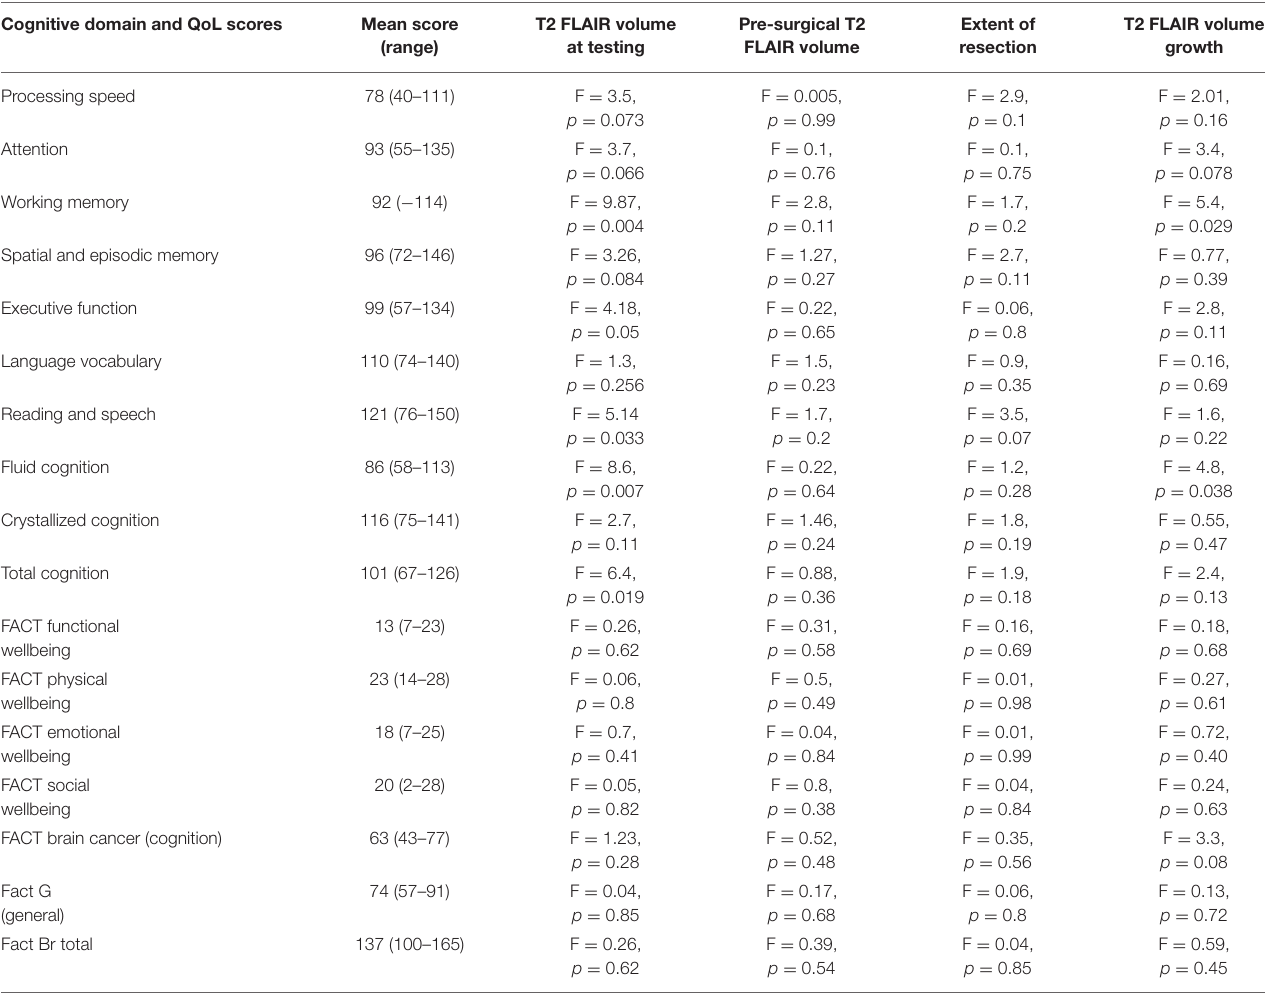
TABLE 4 | Cognitive and quality of life